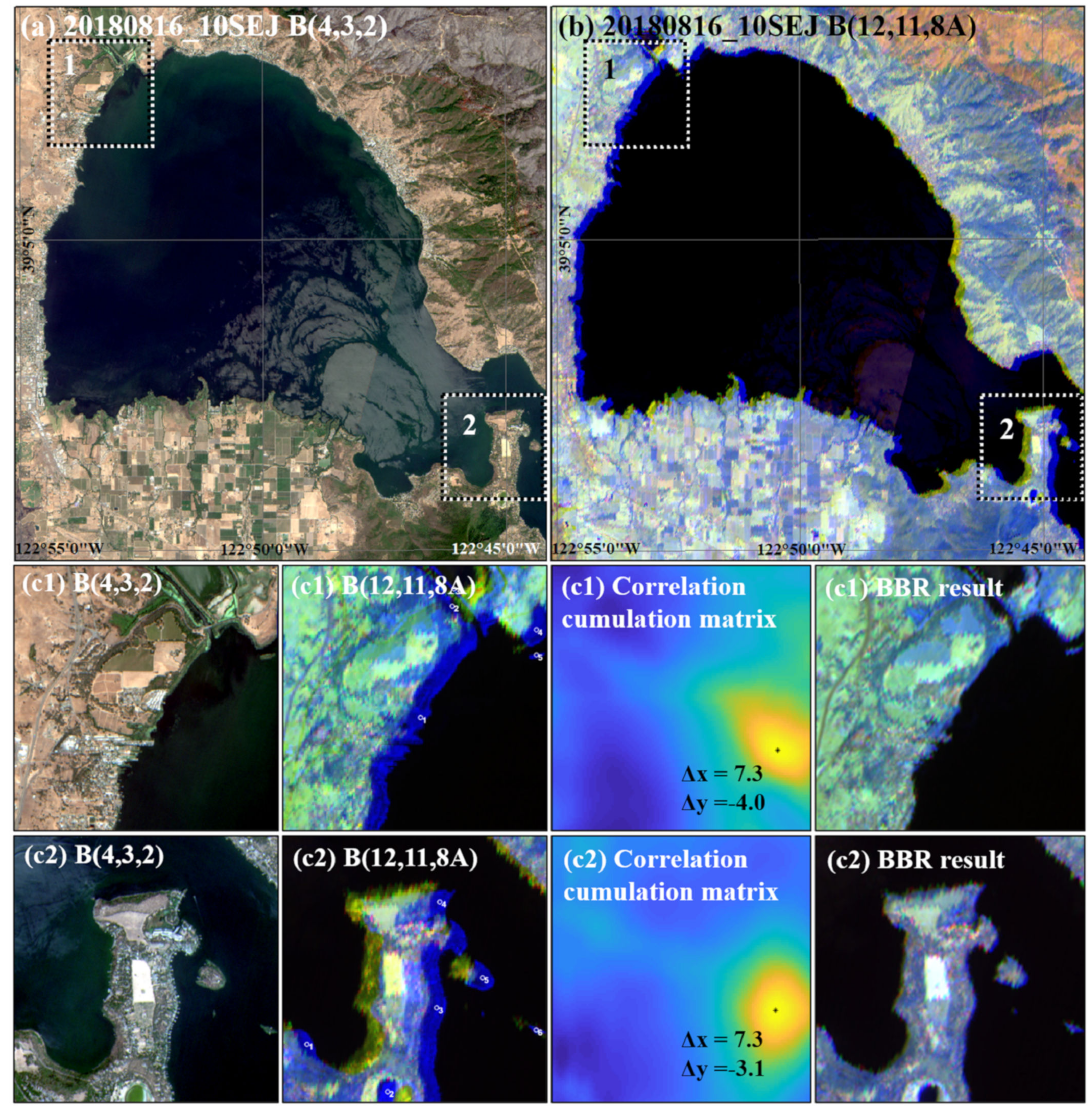
Figure 8. Apparent BBMR exists among MSI Band 8A and SWIR bands (Bands 11 and 12), while there is hardly discernible BBMR among visible bands (Band 2–4) of the same acquisition. ( a ) A subset of true-color MSI image (10SEJ) acquired on 16 August 2018, ( b ) false-color image (Bands 8A, 11, and 12) of the same extent as ( a ), and ( c1 , c2 ) examples of a rough BBR process in two image chips (Bands 12, 11, 8A; size: 168 × 168 pixels) cut from scene